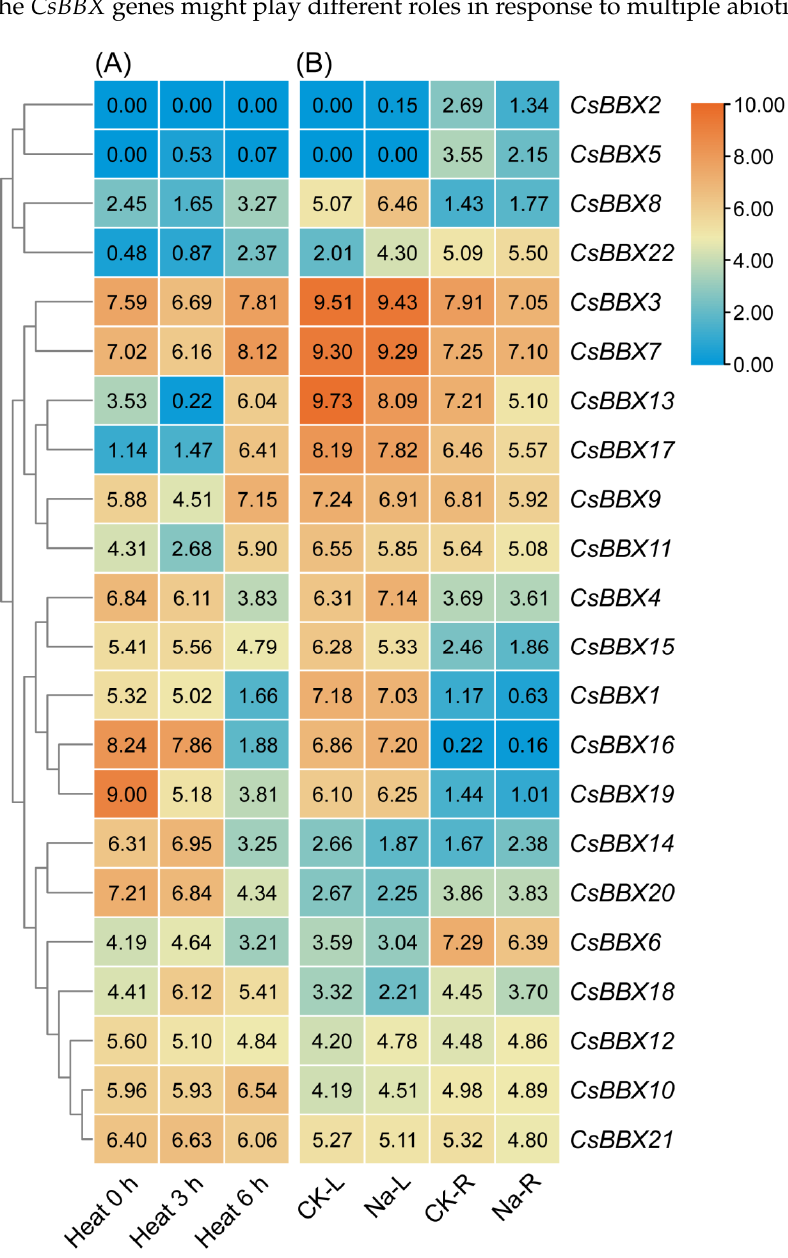
Figure 6. Expression patterns of the CsBBX genes in cucumber exposed to various abiotic stresses based on data retrieved from available RNA-seq data. ( A ) The expression heatmap of the CsBBX genes under heat stress at 0, 3, and 6 h. The data in the boxes indicate log 2 (TPM + 1) values. ( B ) The expression heatmap of the CsBBX genes under salt stress. CK-L and Na-L, and CK-R and Na-R are the control and salt-stressed samples of leaves and roots, respectively. The data in the boxes indicate log 2 (TPM + 1) values.